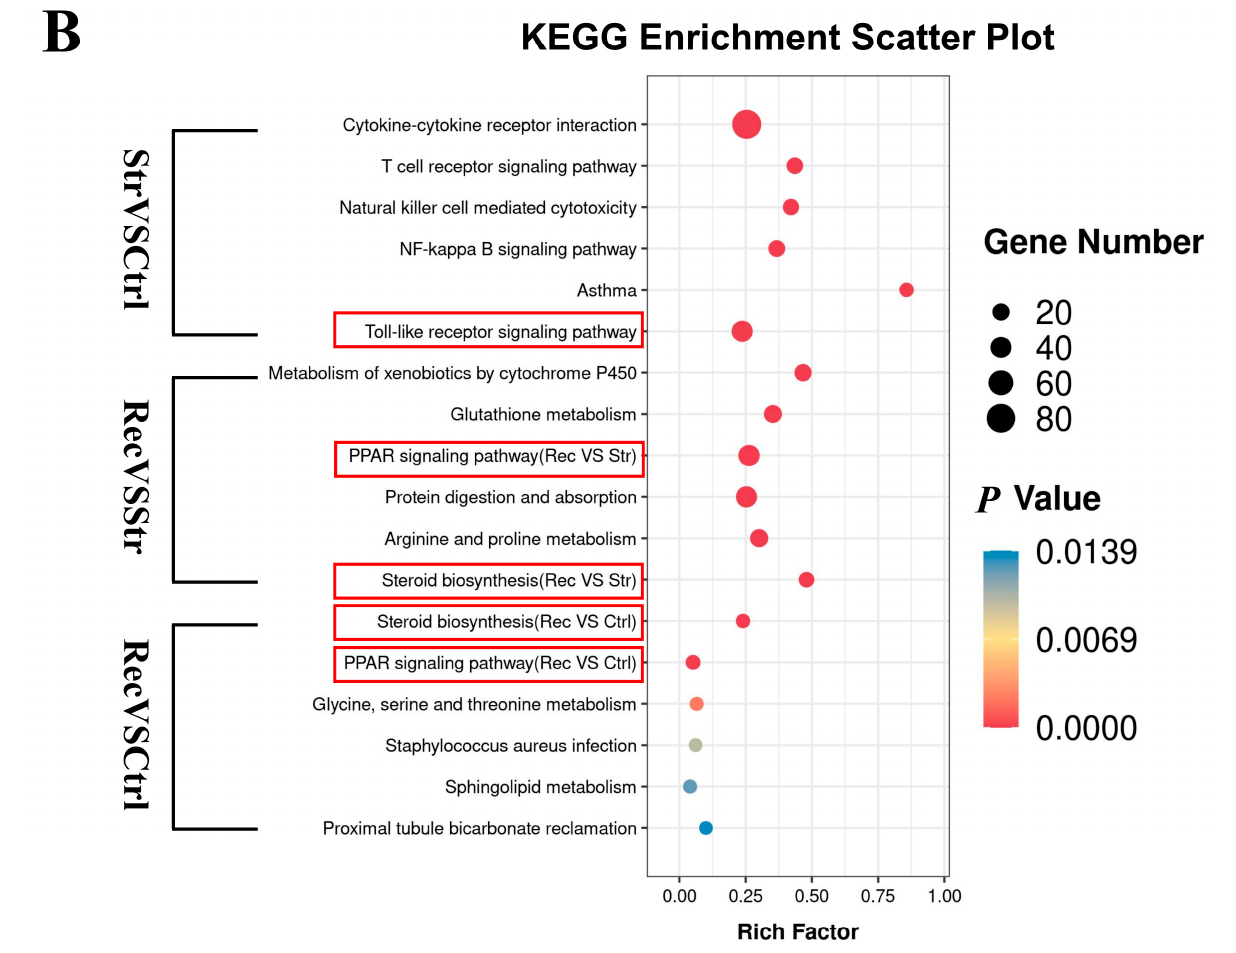
Figure 4. ( A ) The Gene Ontology catalogs with significant enrichment of differential genes were screened, respectively, from MF (molecular function), CC (cellular component), and BP (biological process) of Ctrl (control group) vs. Str (transport 16 h group) vs. Rec (recover group), Str vs. Ctrl, Rec vs. Str, and Rec vs. Ctrl, according to p values. ( B ) The top 6 enrichment KEGG pathways with significant enrichment of differential genes were screened, respectively, from Str (transport groups) vs. Ctrl (control groups), Rec (recover groups) vs. Str (transport groups) and Rec vs. Ctrl according to p values.